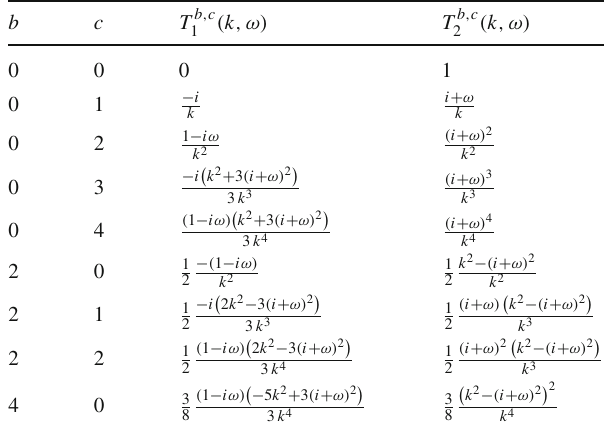
( k ,ω) and T b , c ( k ,ω) that appear in 1 2